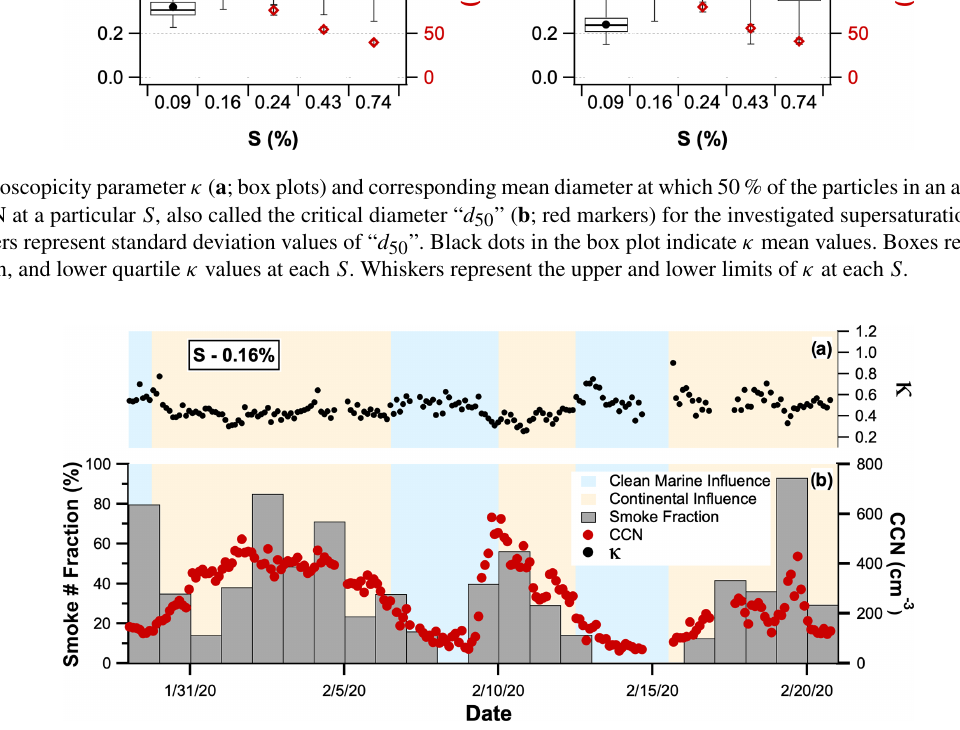
Figure 7. Temporal evolution of the hygroscopicity parameter κ (black dots, a ) and CCN number concentration (red dots, b ), both measured at S = 0 . 16%, and smoke particle number fraction (grey bars, left axis, b ). Background color shadings indicate periods of continental influence (orange) and clean marine influence (blue) determined by HYSPLIT back trajectories and dust mass